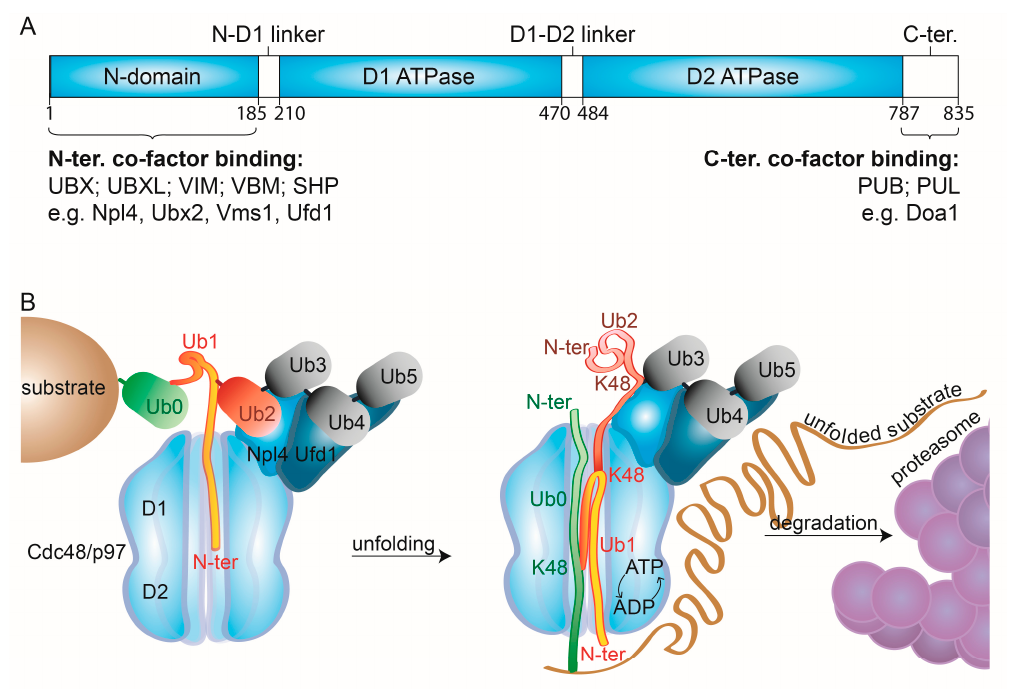
Figure 2. Cdc48 / p97 mechanistic features. ( A ) Linear representation of the domain structure of Cdc48 / p97. ( B ) Molecular modes of action of Cdc48 / p97. Cdc48 and its cofactors, Ufd1 and Npl4, bind the substrate’s ubiquitin chains. Structural analysis shows two distal ubiquitin moieties (Ub 4 & Ub 5 ) recognized by Ufd1, two precedent moieties (Ub 2 & Ub 3 ) by Npl4, and the precedent moiety (Ub 1 ) unfolded and inserted into the catalytic pore of Cdc48, via its N-domain [100]. Subsequently, ATP hydrolysis and ADP-ATP shu ffl ing allow unfolding of additional ubiquitin moieties (Ub 0 ) and of the substrate, enabling its degradation by the proteasome, while Ub 3 to Ub 5 remain folded.